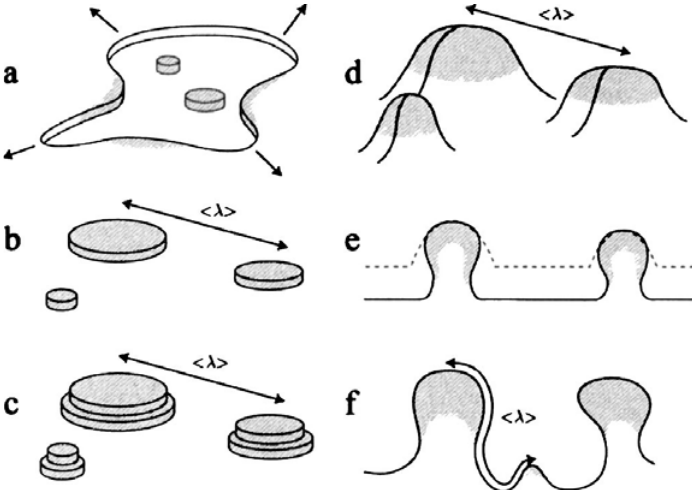
Figure 2. Illustration of porosity formation during dealloying: (a) lateral removal of less noble atoms (uncolored) leading to clustering of noble atoms (shaded) on surface; (b) supplied with remaining noble atoms from dissolution, clusters coarsen until the next alloy layer is attacked, as the characteristic length < λ > appears; (c) noble atom-capped hills form as the second layer of alloy dissolves, while the characteristic length between hills remains the same; (d) less noble atoms can accumulate at the bases of hills, since their perimeters are widening, without changing the characteristic length; (e) undercutting of hills (compared the original morphology denoted with a dashed line) and increase in average distance between hills measured along the alloy-electrolyte interface; (f) new noble atom hills nucleate as the hill-hill distance along the alloy-electrolyte distance is approximately twice the characteristic length. [Reproduced with permission from J. Electrochem. Soc . 2004 , 151 , C614–C626. © 2004, The Electrochemical